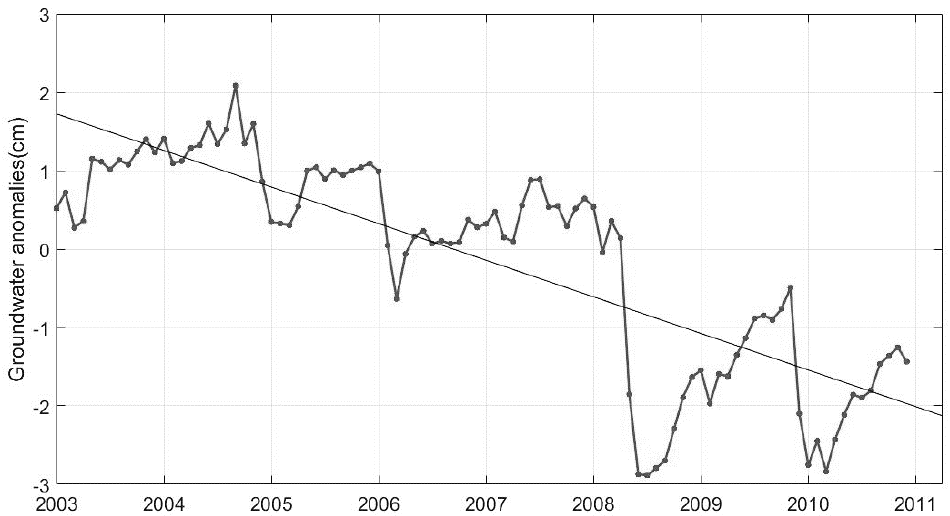
Figure 11. Time series of the groundwater anomalies obtained from GRACE after subtracting the oil and soil moisture contribution, years 2003 to 2011.